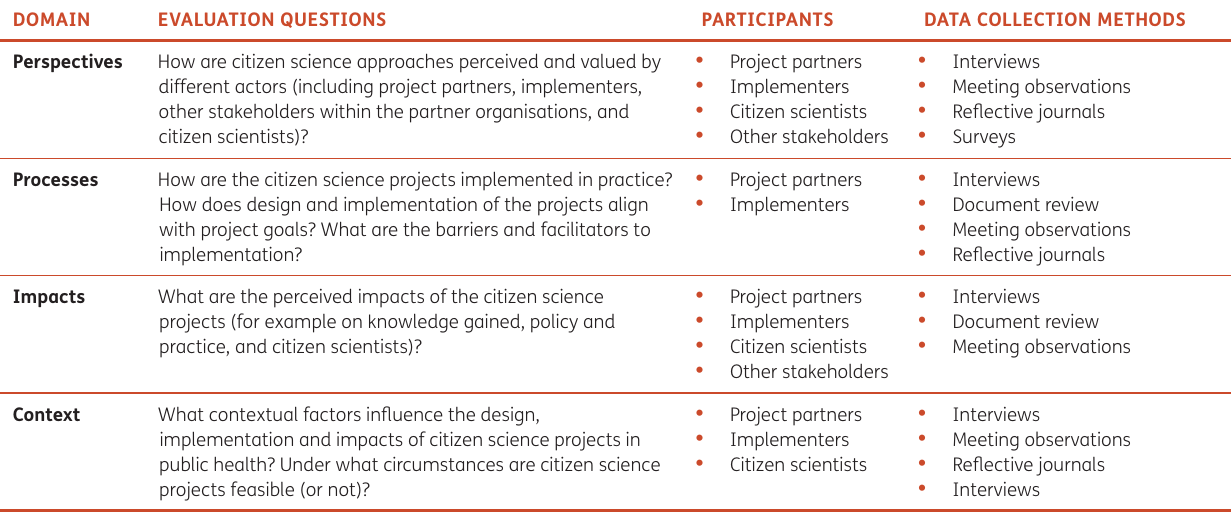
Table 2 Overview of evaluation domains, questions, participants, and data collection